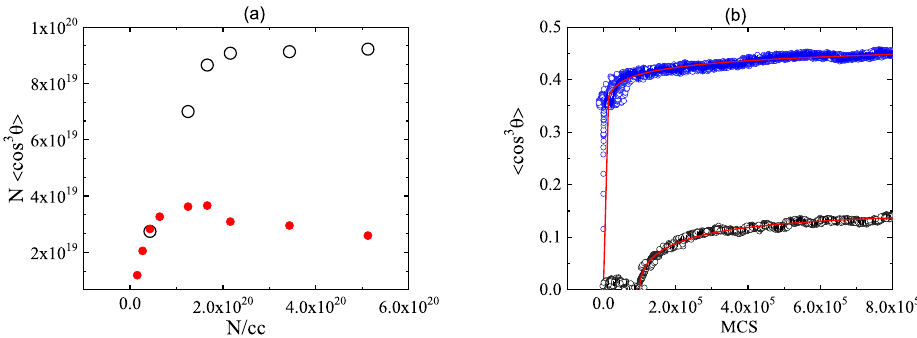
( 2 ) as a function of number density N : ZZZ